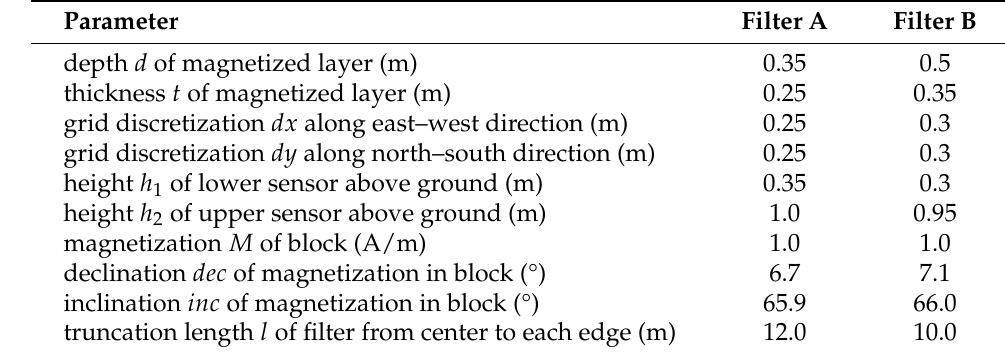
Table 1. Parameters and their values for filters A and